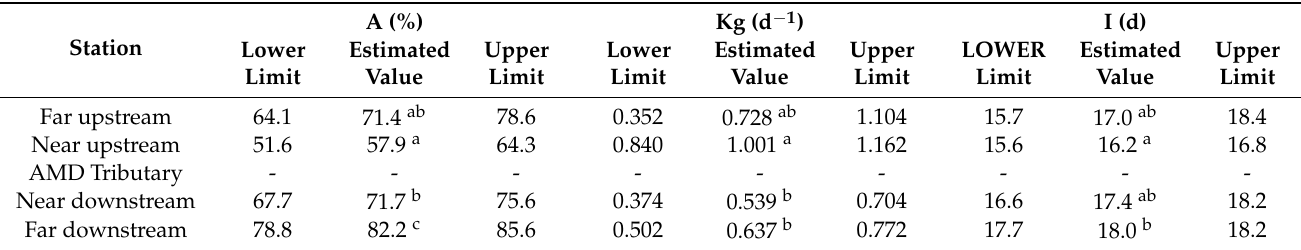
Table 4. Kinetic parameters of emergence modelled for stations (mean and 95% confidence intervals). A is the maximal percentage reached (%), kg the emergence constant (d − 1 ) and I the time at the inflection point (d). Different letters indicate significant differences between stations.